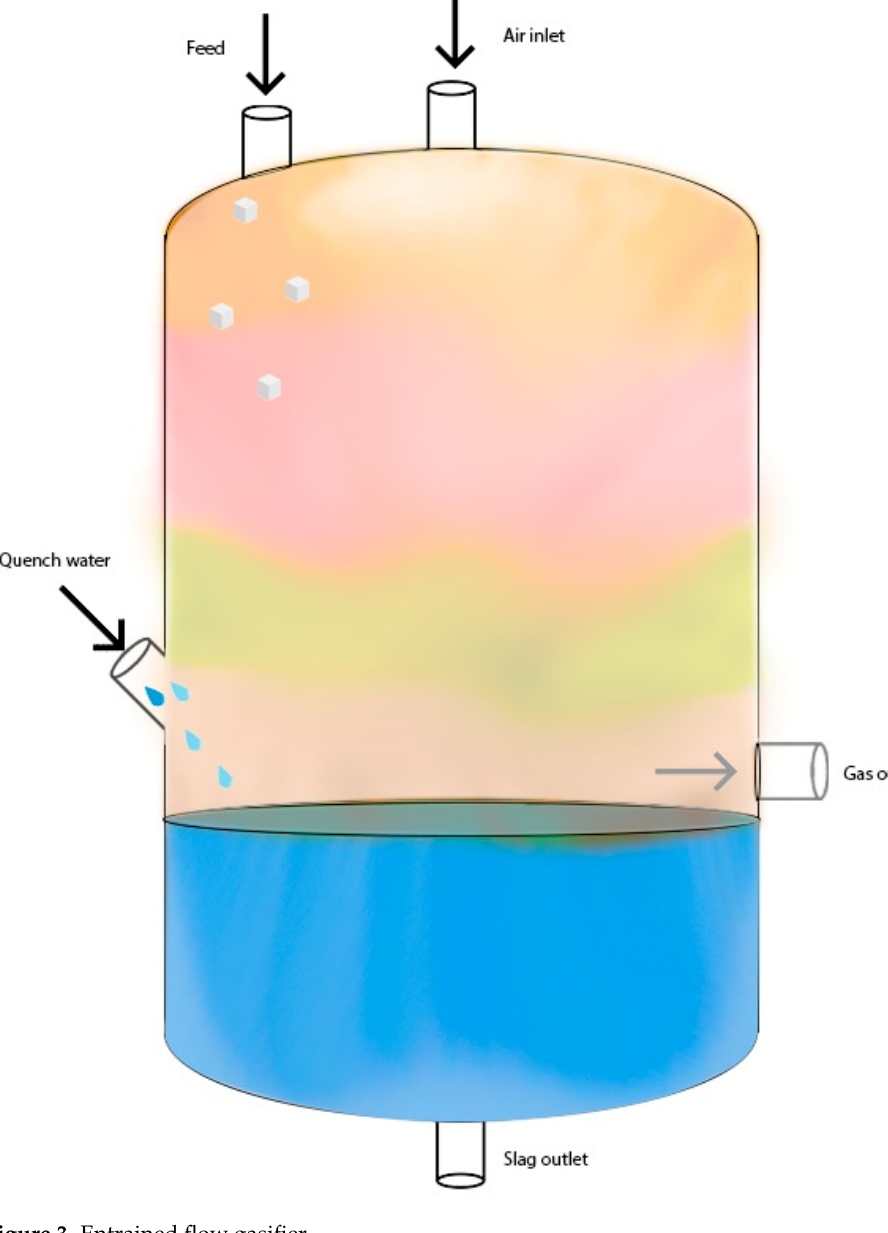
Figure 3. Entrained flow gasifier.